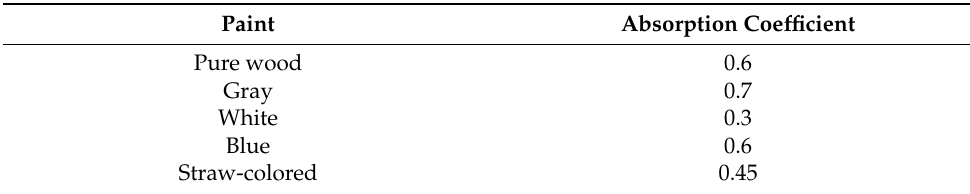
Table 3. Absorption coefficients for different types of paint